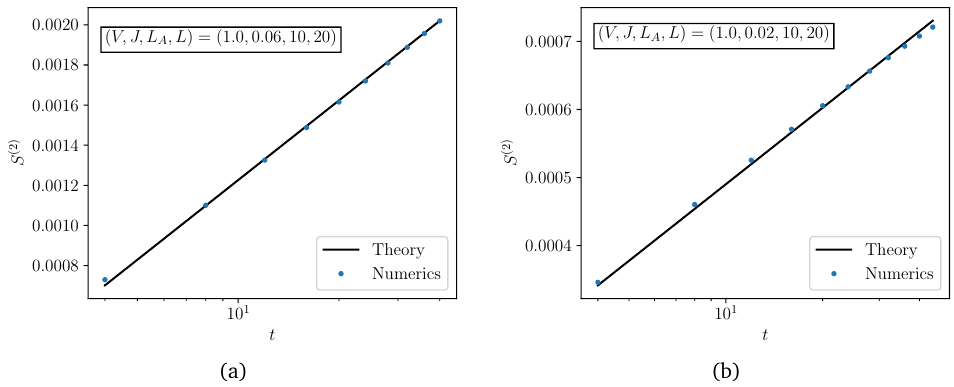
Figure 11: (a) S ( 2 ) as a function of log t in the ( 4,4 ) model in the J / V (cid:28) 1 limit. The theory result is drawn from Eq. (49) with proper cutoff parameter ε . (b) The same plot in the ( 2,2 ) model in the J / V (cid:28) 1 limit. The theory result is drawn from Eq. (50) with proper cutoff parameter ε